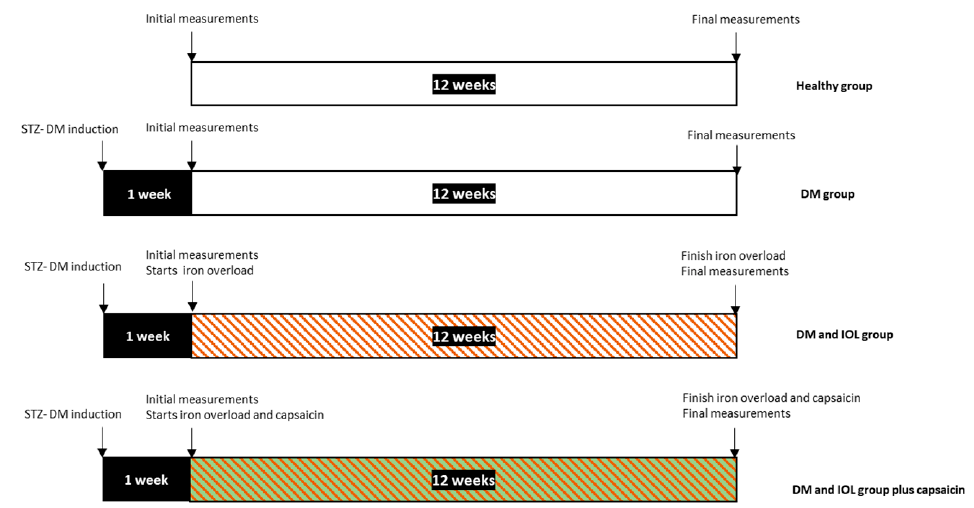
Figure 5. Timeline of the experimental groups.